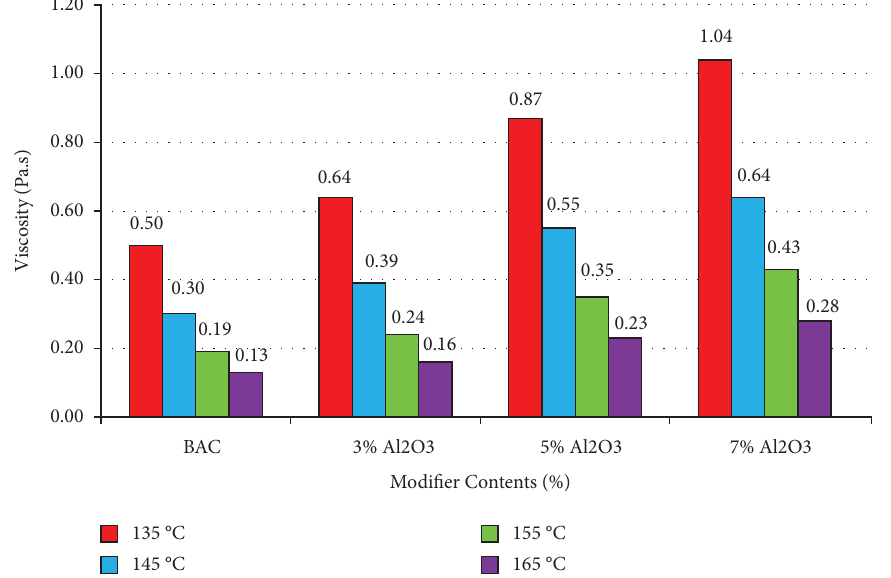
Figure 3: Te infuence of nanoparticles on the viscosity of asphalt